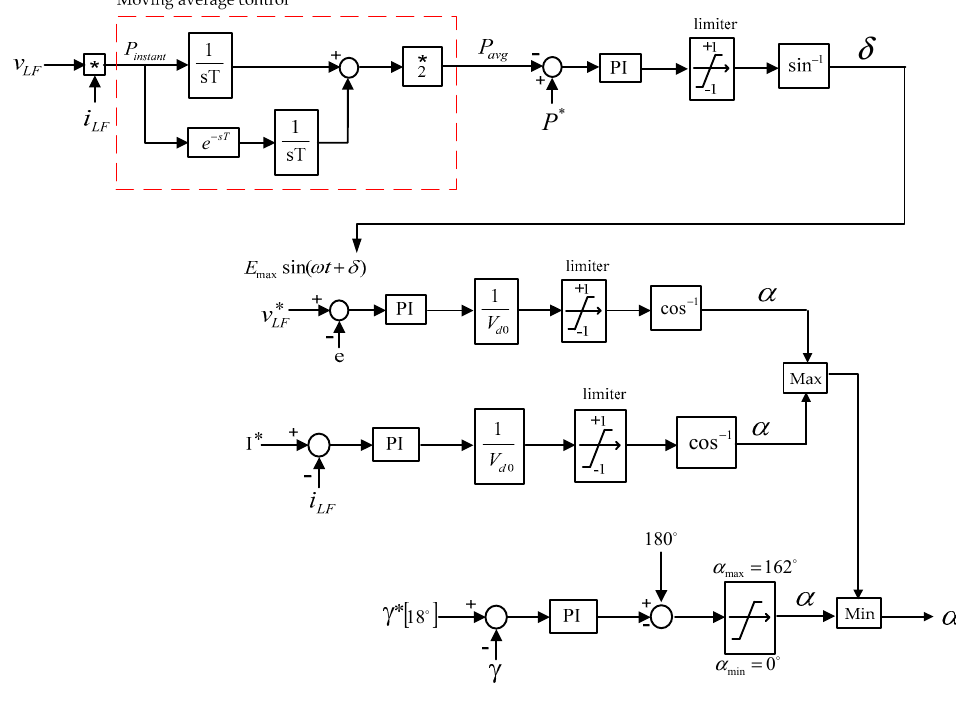
Figure 8. The proposed overall control scheme of LFAC.